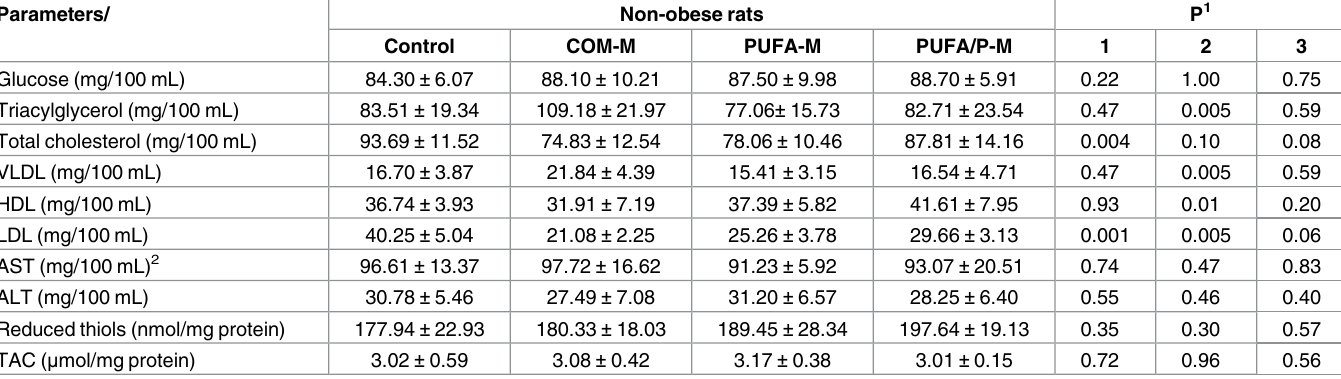
Table 3. Plasma biochemical profile of non-obese rats fed a diet supplemented with common milk (COM-M), milk enriched with polyunsaturated fatty acids (PUFA-M) or milk enriched with PUFA and polyphenols (PUFA/P-M). Parameters/